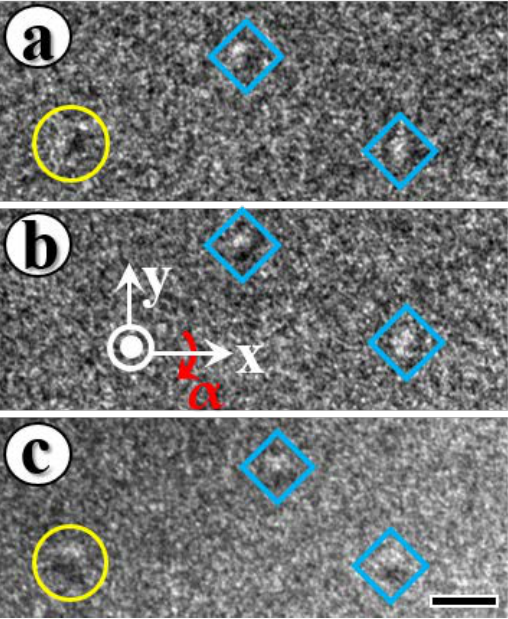
type skyrmion in multilayers [44]. In addition to the extremely rare N é el-type skyrmions that have been identified, the presence of domain contrast at any tilting angle indicates nonideal N é el-type skyrmions for those marked with a blue diamond.